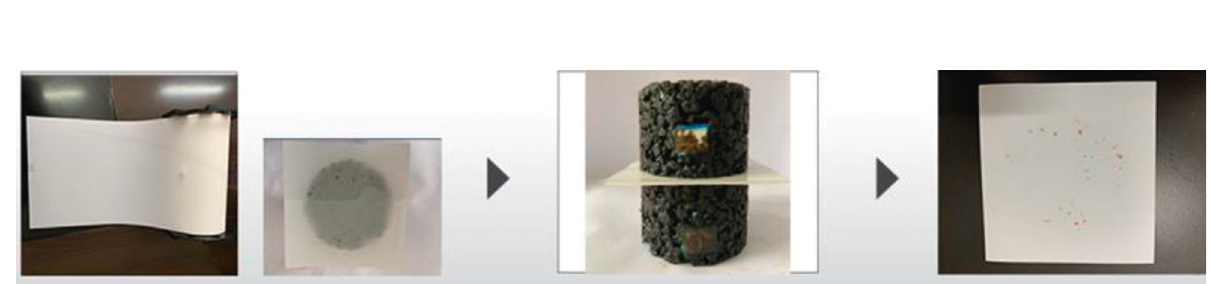
Figure 1: Pressure